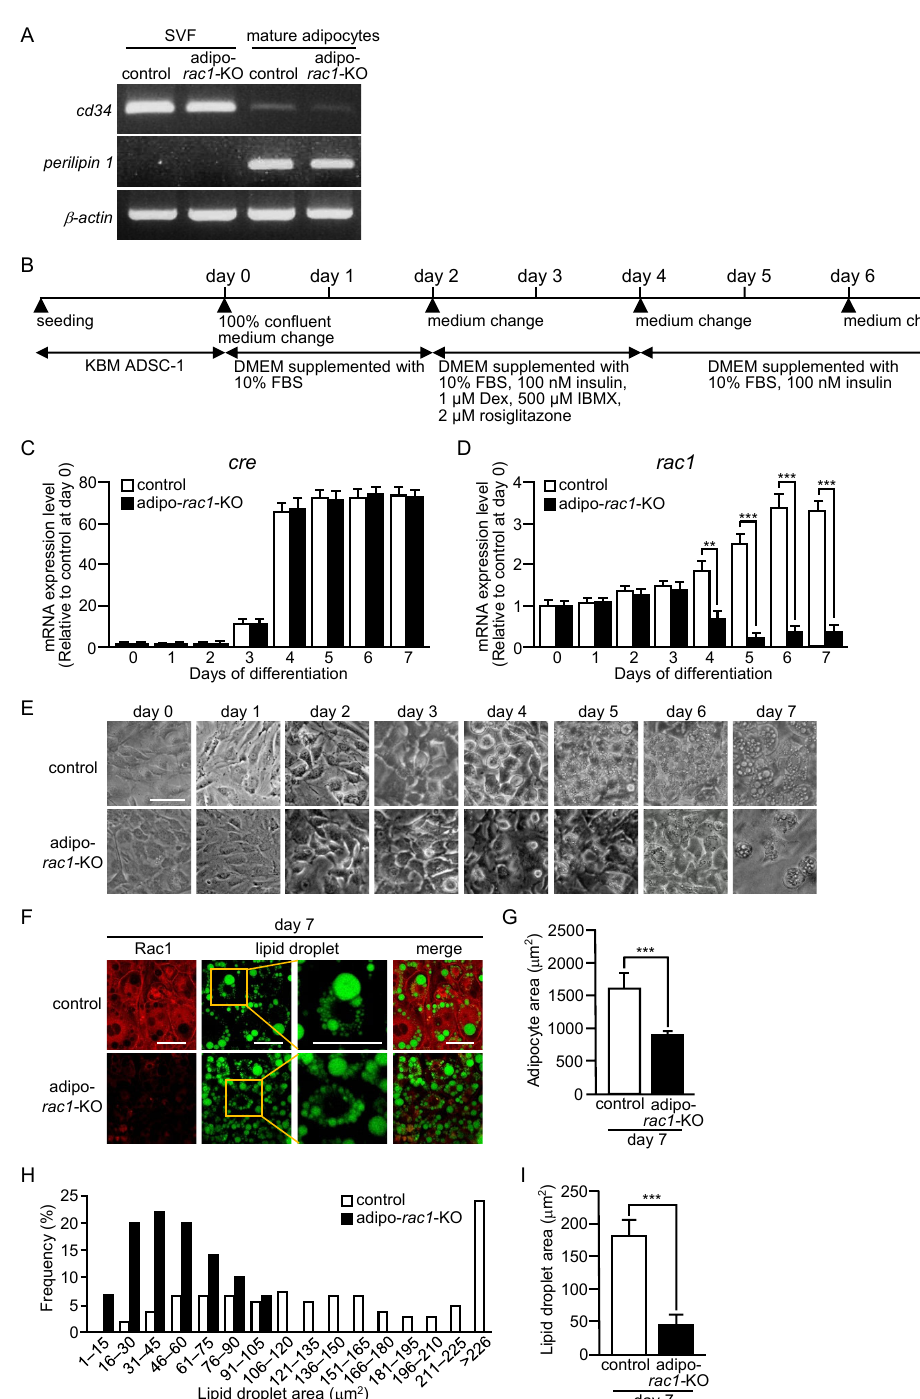
Figure 1. Differentiation of adipose progenitor cells obtained from mouse WAT into adipocytes in vitro. ( A ) The expression of cd34 and perilipin 1 genes in the SVF and mature adipocytes. Relative mRNA levels were determined by RT-PCR analysis. The β -actin gene served as a loading control. ( B ) Schematic representation of the differentiation protocol. The day when cells reached confluence was referred to as day 0. ( C ) The expression of the cre gene during adipogenic differentiation in vitro. Relative mRNA levels in cells derived from control and adipo- rac1 -KO mice were determined by quantitative RT-PCR analysis. Data are shown as means ± S.E. ( n = 3). ( D ) The expression of the rac1 gene during adipogenic differentiation in vitro. Relative mRNA levels in cells derived from control and adipo- rac1 -KO mice were determined by quantitative RT-PCR analysis. Data are shown as means ± S.E. ( n = 3). ** p < 0.01, *** p < 0.001 (Student’s t test). ( E ) Phase-contrast images of cells derived from control and adipo- rac1 -KO mice during adipogenic differentiation in vitro. Scale bar, 50 µ m. ( F ) Fluorescent staining of Rac1